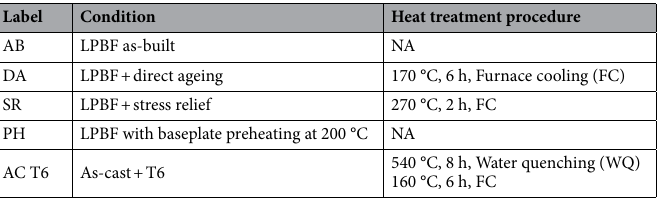
Table 1. Labels used for the respective sample conditions with details on the heat treatment